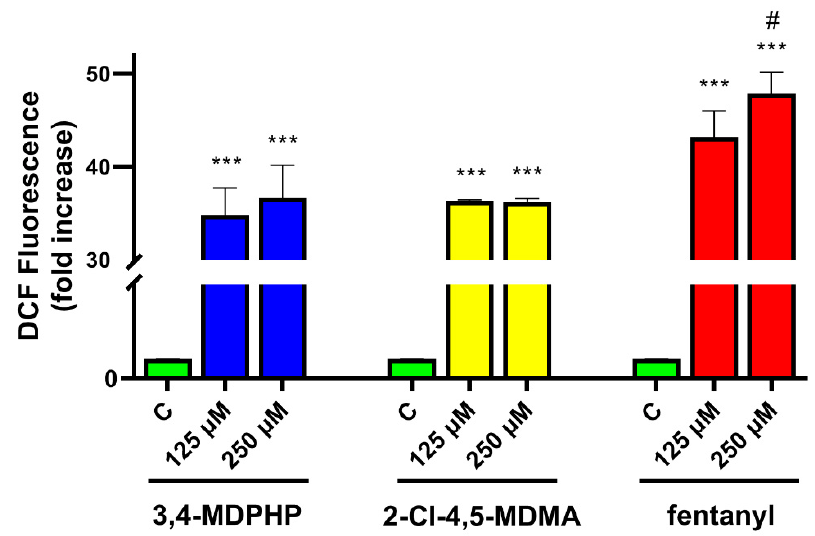
Figure 4. 3,4-MDPHP, 2-Cl-4,5-MDMA, and fentanyl increased ROS production in dopaminergic-differentiated SH-SY5Y cells. Dopaminergic-differentiated SH-SY5Y cells were treated for 24 h with compounds (125 and 250 µ M) or culture medium containing 1% of DMSO as a negative control. Fluorescence data from DCFH-DA assay were normalized to negative controls (no drug exposure, set to 1), expressed as mean ± SEM, and were from three independent experiments with three replicates for each concentration of the compounds. Two-way ANOVA followed by Tukey’s post-hoc. *** p < 0.001 compared to their respective controls and # p < 0.05 vs. 3,4-MDPHP and 2-Cl-4,5-MDMA.